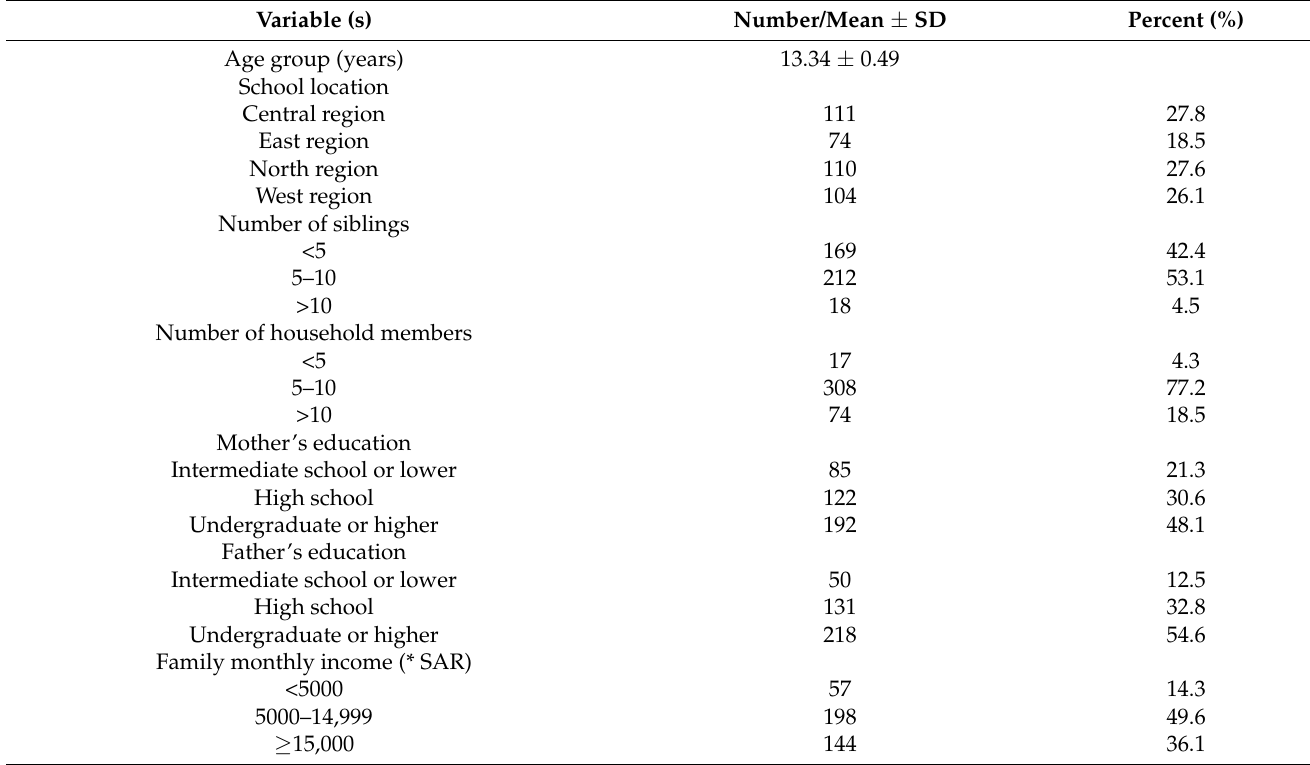
Table 1. Sociodemographic and personal characteristics of the